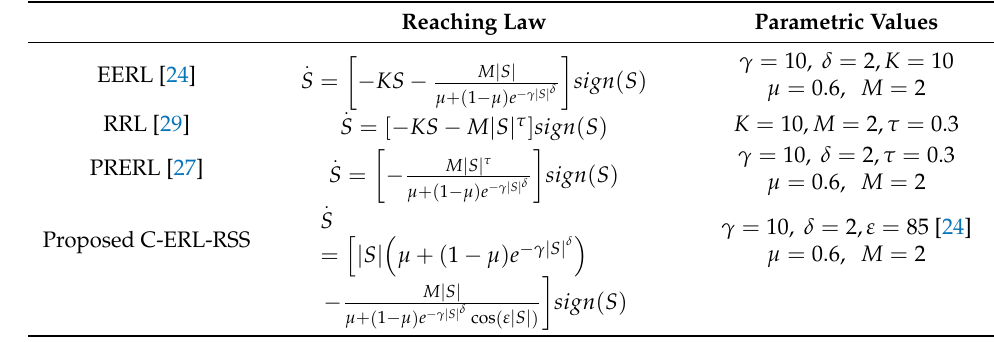
Figure 3. Reaching law gain adaptive behavior w.r.t distance of the surface from the equilibrium point. Table 1. Parametric values of the reaching